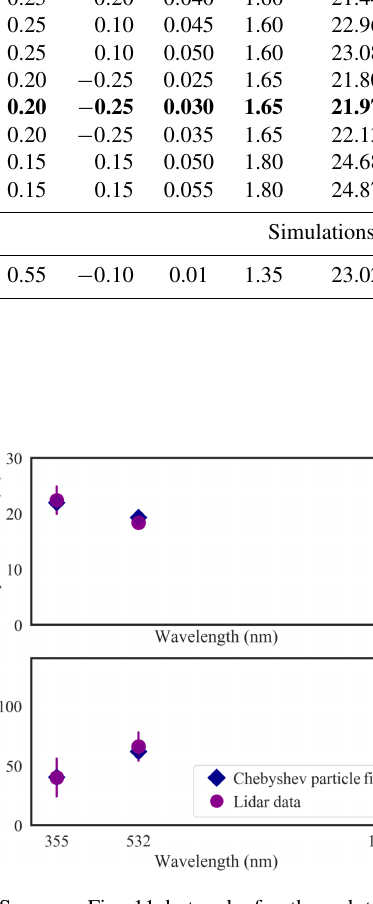
Figure 12. Same as Fig. 11 but only for the solution found to minimize the cost function of Eq. (8). Again, purple circles and lines correspond to measurements and measurement uncertainties on 22 August 2017, in Leipzig, Germany, while dark blue dia- monds correspond to simulations assuming Chebyshev particles of the second degree ( T 2 ) that resemble oblate near-spherical parti- cles, with deformation parameter u = − 0 . 25, mean geometric ra- dius r g = 0 . 2µm and a wavelength-independent complex refractive index m = 1 . 65 + i 0 . 03 (this is the solution highlighted in bold in Table